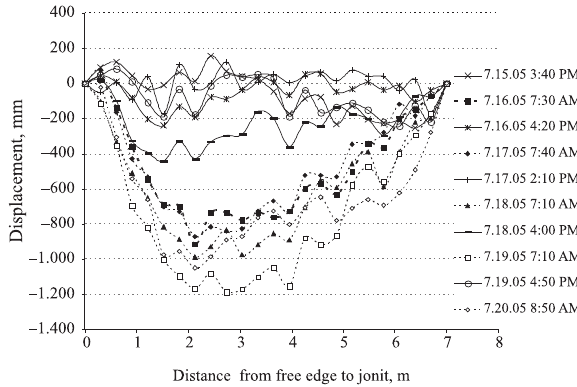
Fig. 8. Diagonal slab curvature profi